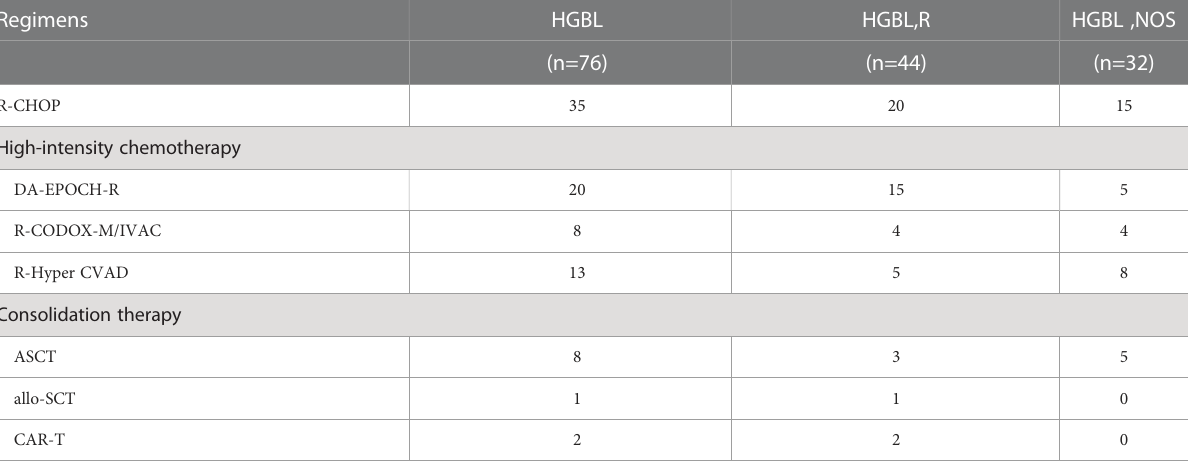
TABLE 1 First-line